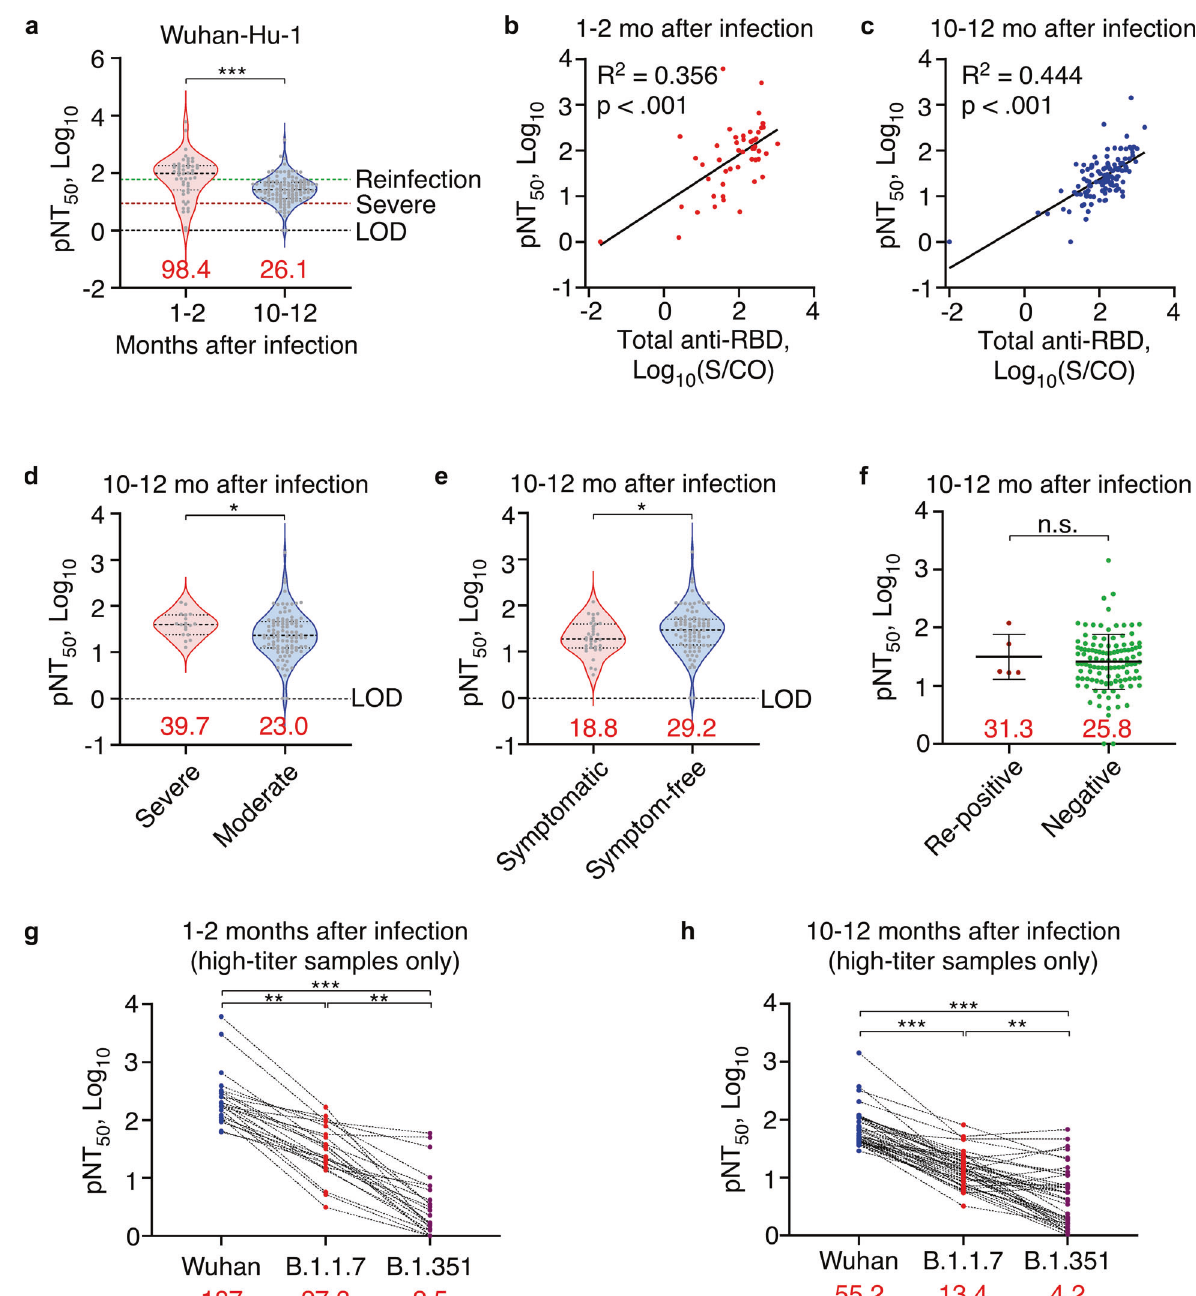
Fig. 3 Time- and variant-dependent reduction of serum neutralization levels. a Neutralization levels of 1 – 2-month post-infection ( n = 50) and 10 – 12-month post-infection sera ( n = 119) against Wuhan-Hu-1 pseudovirus measured by PNA. Green and crimson dotted lines indicate 50% protective threshold against detectable and severe re-infection, respectively. b , c Scatter plot showing linearity of neutralization titers against Wuhan-Hu-1 pseudovirus with total anti-RBD antibodies in 1 – 2-month post-infection ( n = 50) ( b ) or 10 – 12-month post-infection sera ( n = 119) ( c ). Linear regression was performed on all datapoints after log-transformation. d Neutralization levels of 10 – 12-month post-infection sera against Wuhan-Hu-1 pseudovirus among severe ( n = 18) and moderate COVID-19 survivors ( n = 101). e Neutralization levels of 10 – 12-month post-infection sera against Wuhan-Hu-1 pseudovirus among symptomatic ( n = 34) and symptom-free COVID-19 survivors ( n = 85). f Neutralization levels of 10 – 12-month post-infection sera against Wuhan-Hu-1 pseudovirus among viral RNA re-positive ( n = 5) and consistently negative COVID-19 survivors ( n = 114). Bar = mean ± SD. g , h Before-after plots of neutralization levels against Wuhan-Hu-1, B.1.1.7 or B.1.351 pseudovirus in 1 – 2-month post-infection ( n = 24) ( g ) or 10 – 12-month post-infection sera ( n = 42) ( h ). Data were analyzed by Friedman test with post hoc comparisons. Red numbers indicate median value for violin plots or mean value for scatter plots. Dotted lines indicate the diagnostic cut-off (CO) for total anti-RBD antibody titers or the limit of detection (LOD) for neutralization assays. * p < .05, ** p < .01, *** p < .001, n.s. not signi fi cant